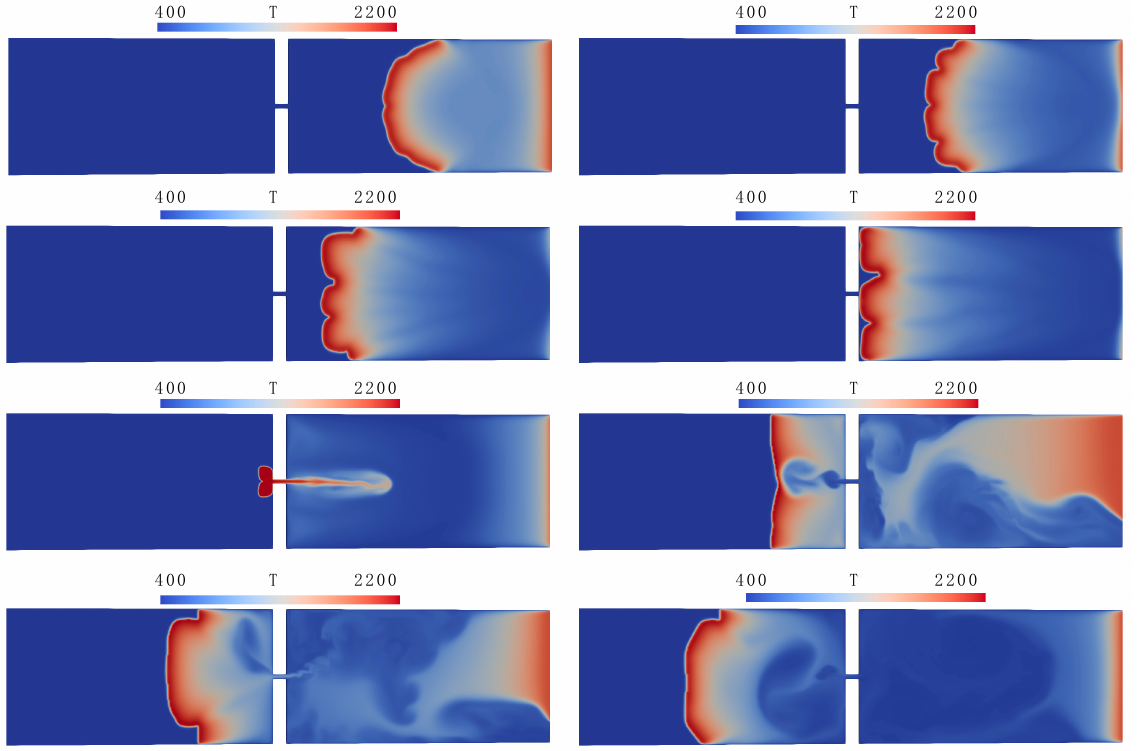
Figure 10. Longitudinal ( x ) velocity component distributions in the symmetry plane z = 0 at times 500, 900, 1100, and 1560 ms ( top to bottom , left to right ).